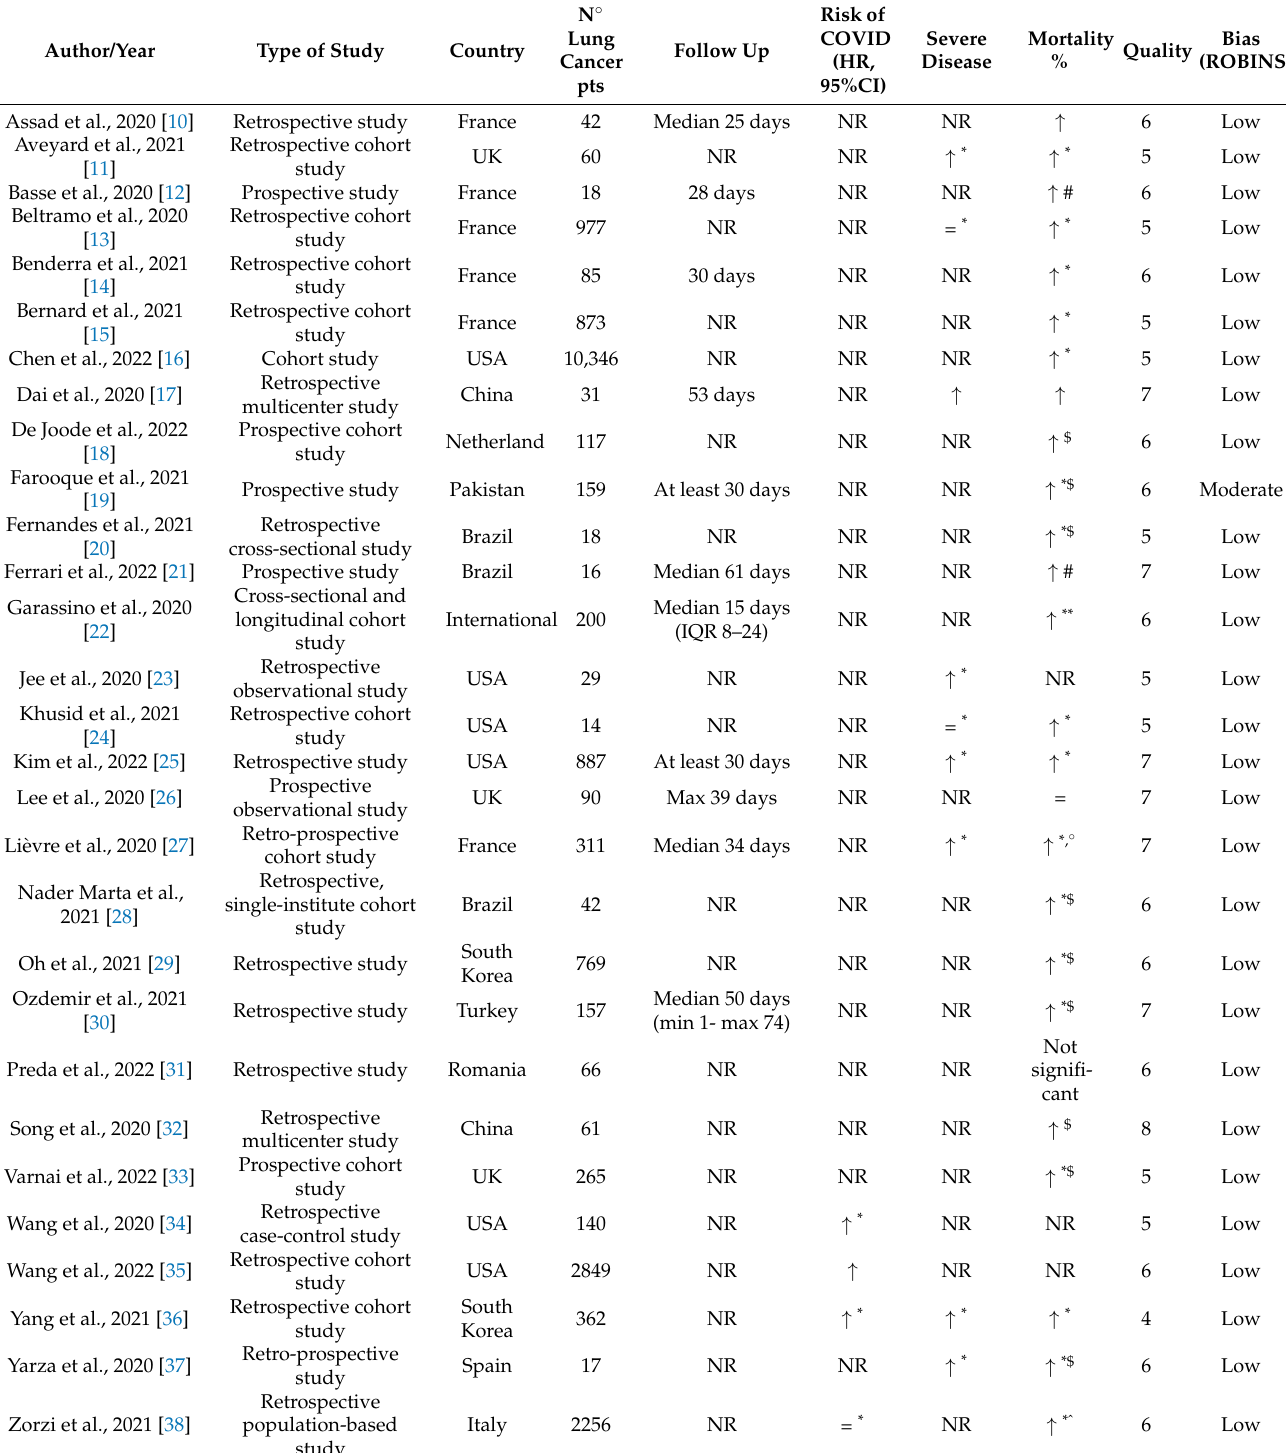
Table 1. Characteristics of included